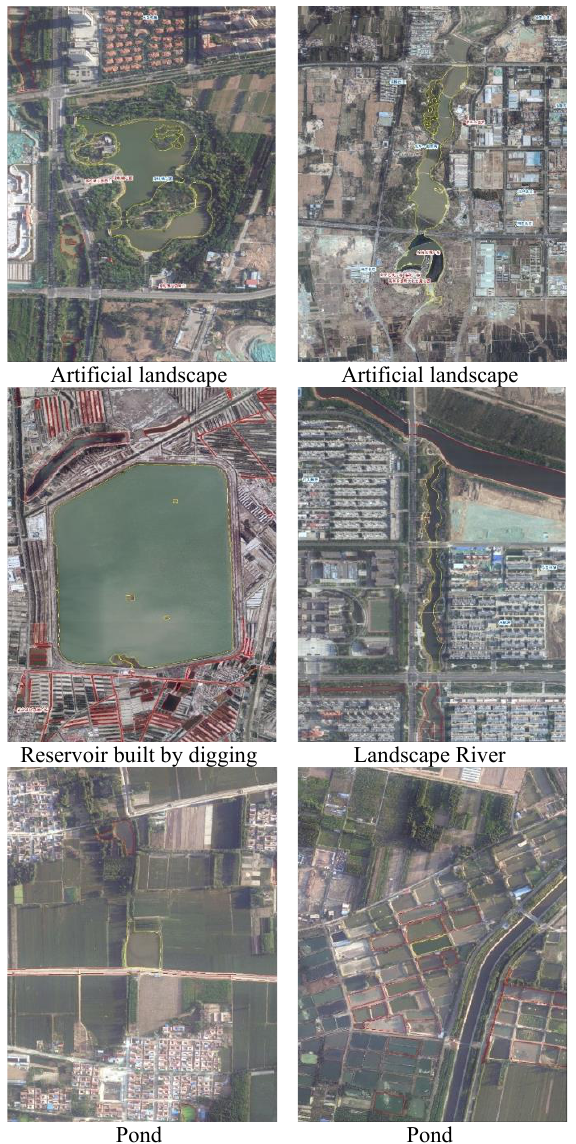
Figure 2 . Schematic diagram of typical artificial lake classification